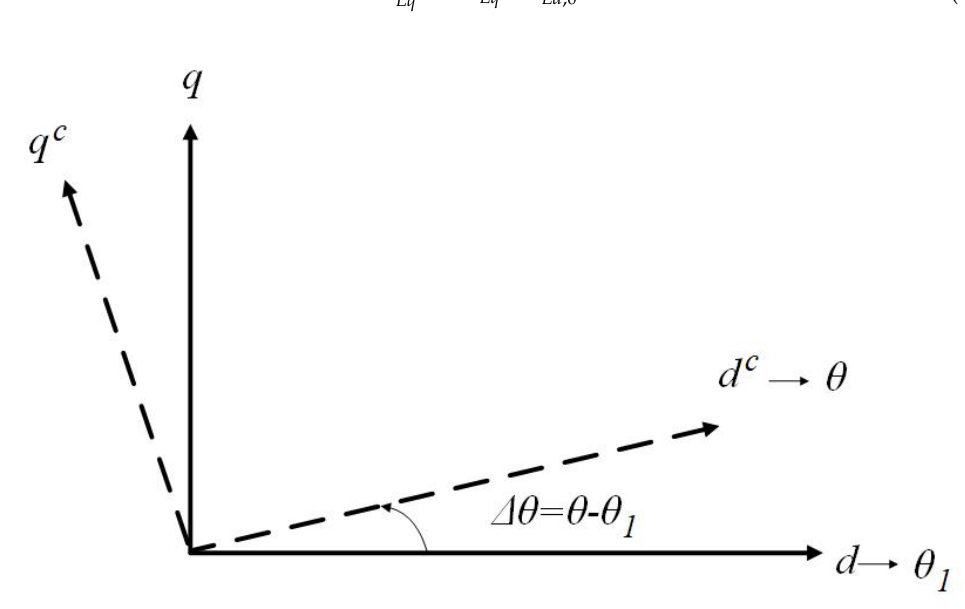
Figure 2. Control and grid dq frame used for the VSC.